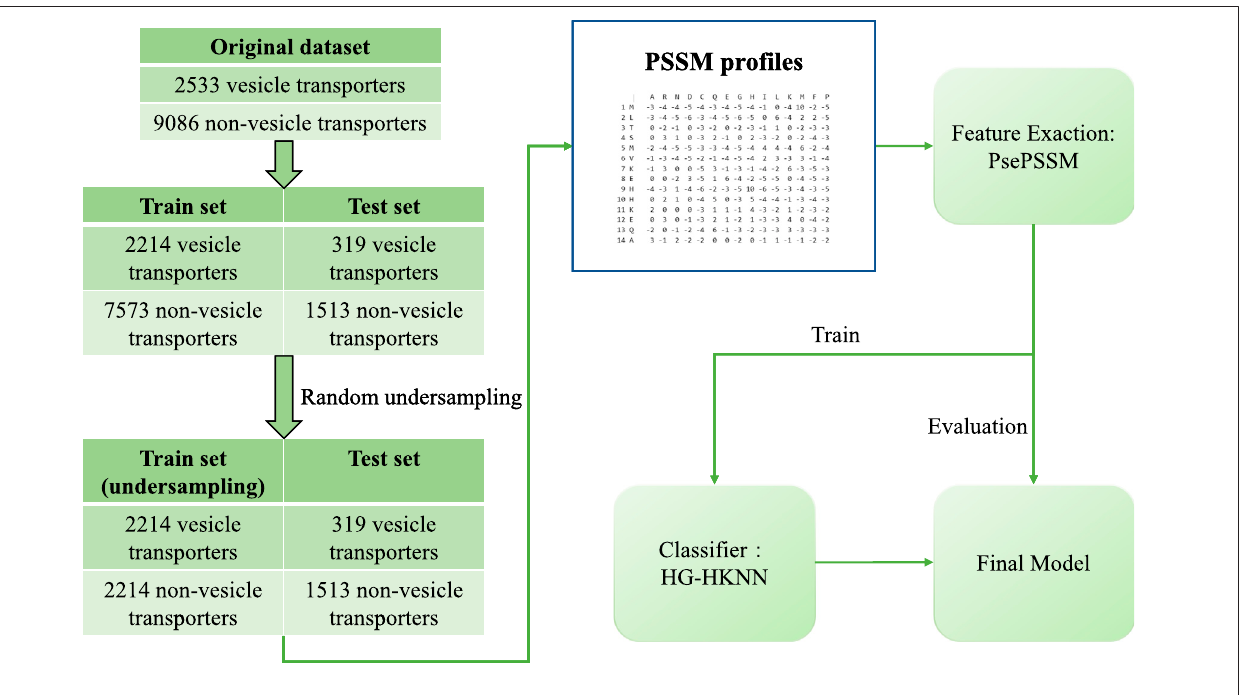
FIGURE 1 | Flowchart of our